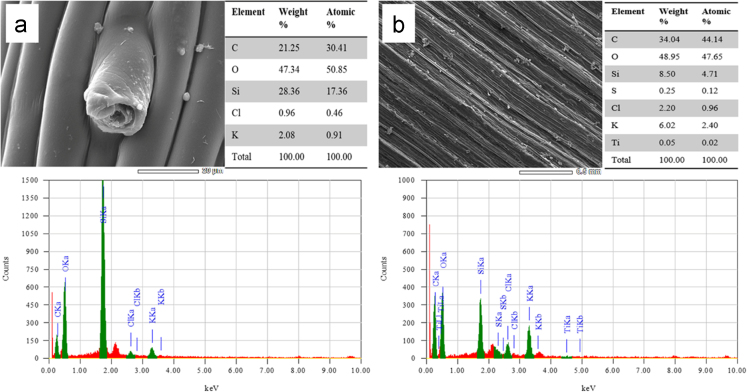
SEM and EDX analysis of wheat leaves at (a) 0 mg kg−1, and (b) 60 mg kg−1 of TiO2 NPs treatment. The EDX spectrum was measured at 20 keV.